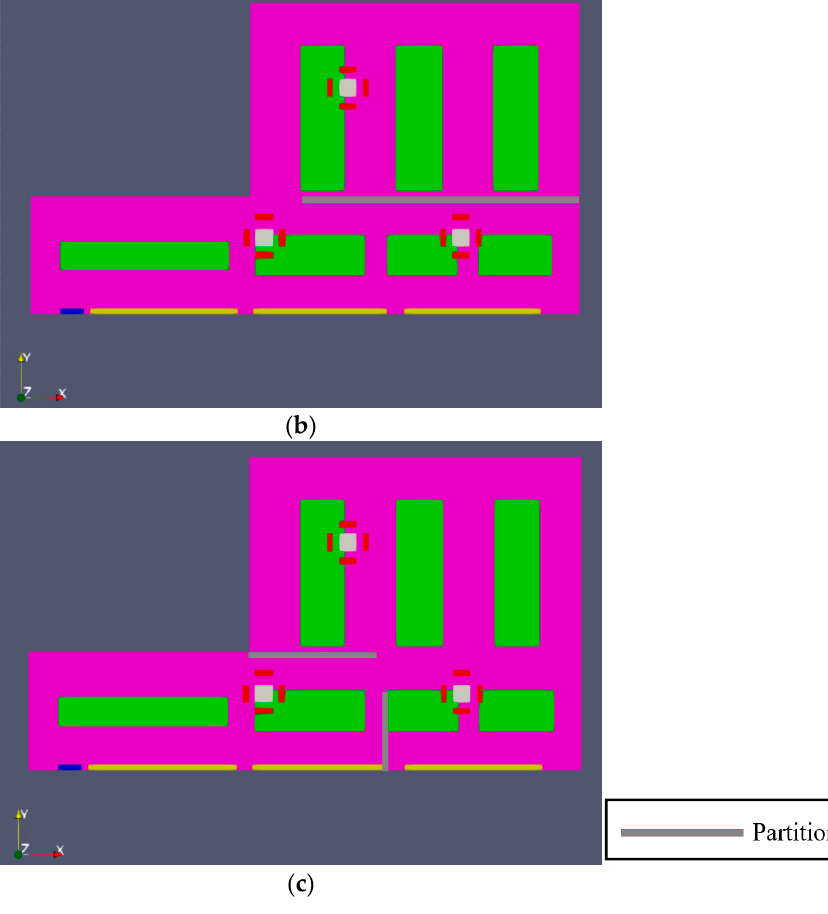
Figure 12. BlockMesh of three partition proposals: ( a ) case a; ( b ) case b; and ( c ) case c. Table 8. Winter simulation